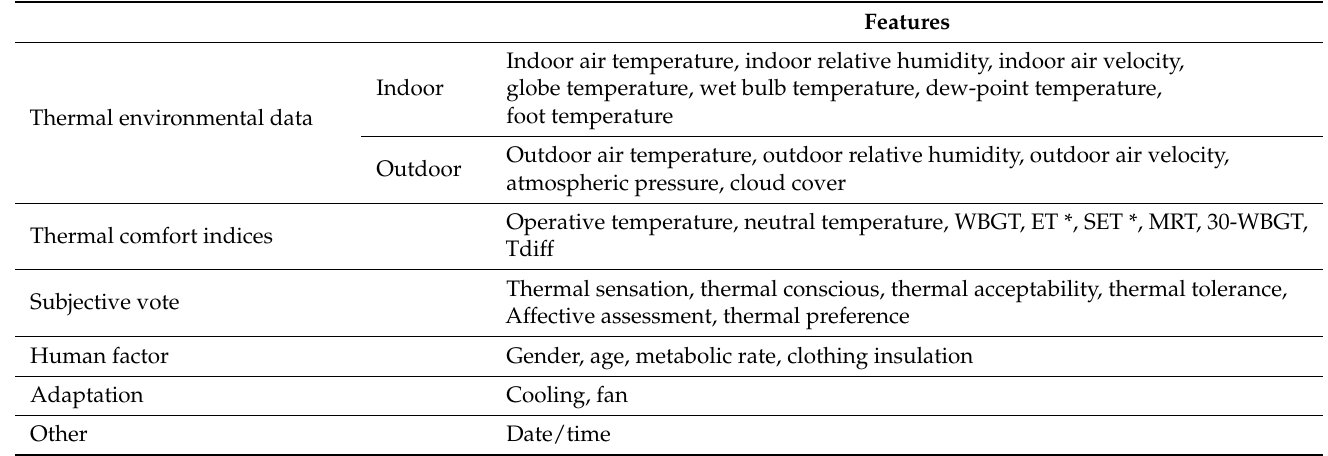
Table 7. Features used in the